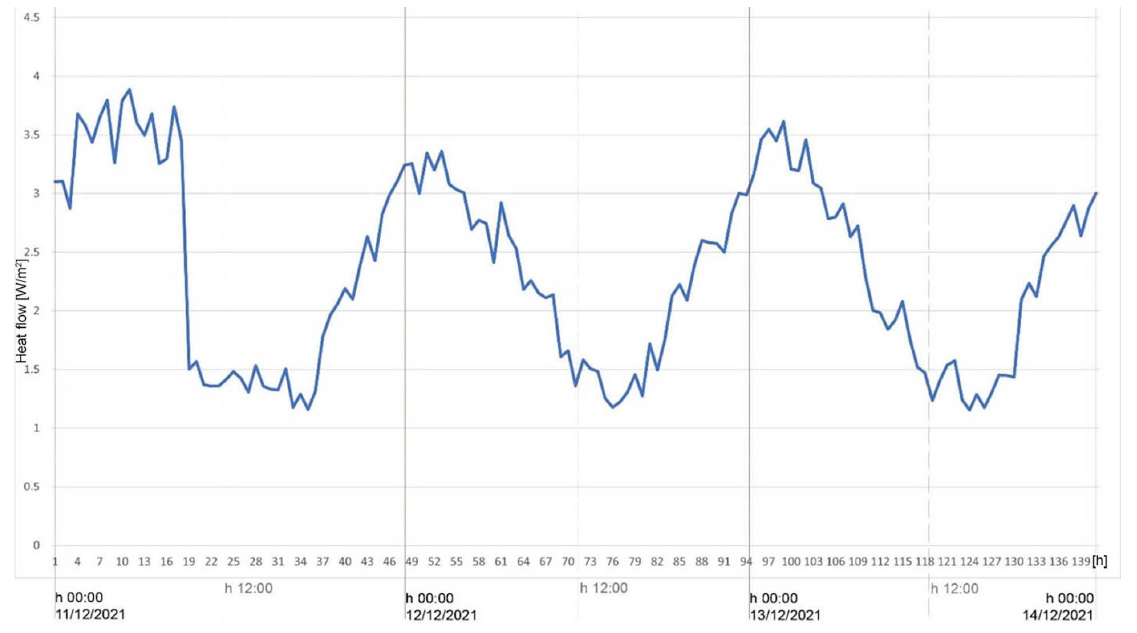
Figure 19. Tuff perimeter wall heat flow diagram as a function of time: post operam.